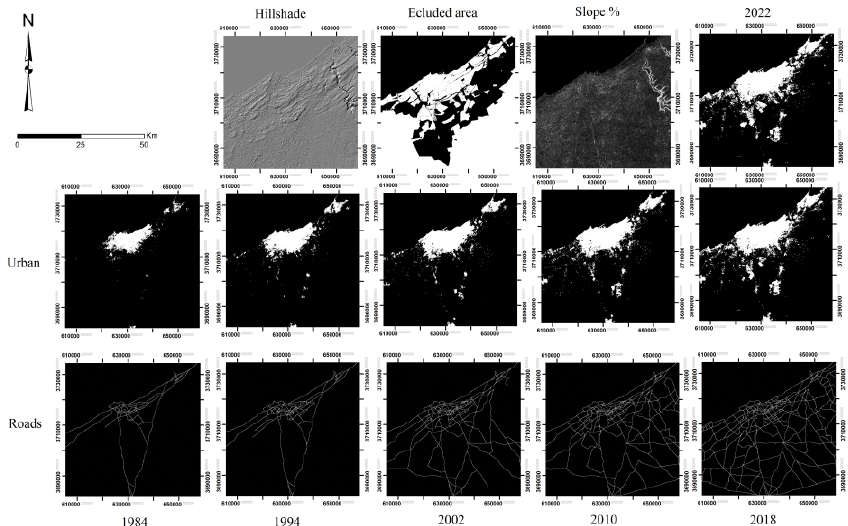
Table 2. Data requirements for the model